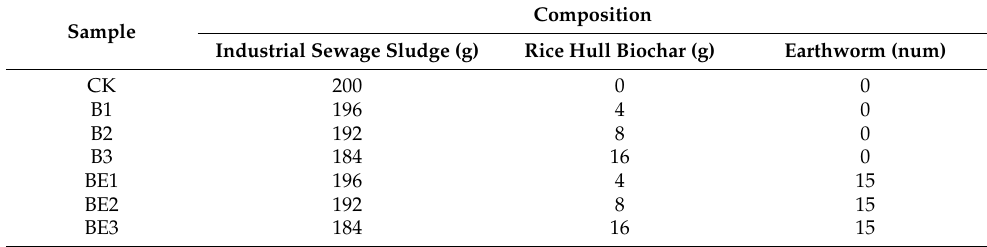
Table 1. Composition of different treatments used in this